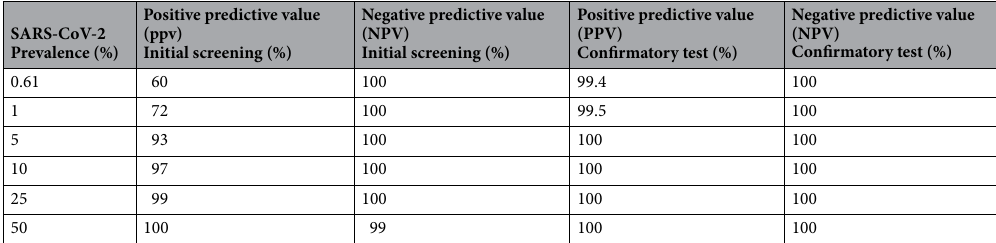
Table 3. Positive and negative predictive value calculations after initial screening and confirmatory test of positive